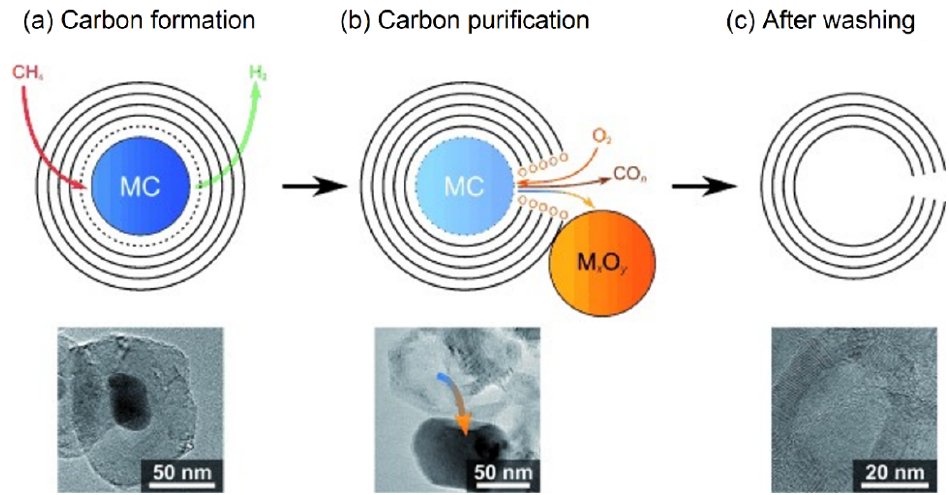
Figure 24. Formation and purification model steps of CNOs